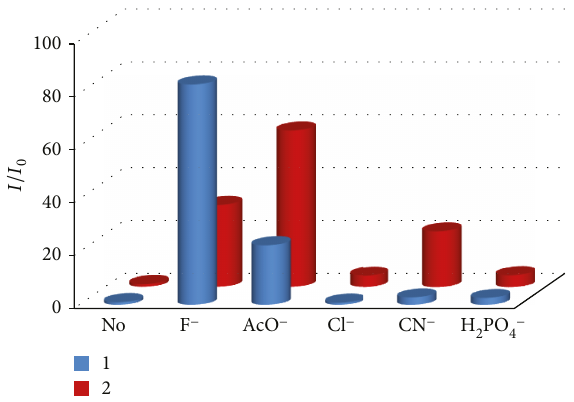
Figure 6: Relative changes of fl uorescence intensity ( I / I compounds 1 and 2 in acetonitrile ( 2 0 · 10 − 6 M ) in the presence of anions ( 2 0 · 10 − 5 M ).